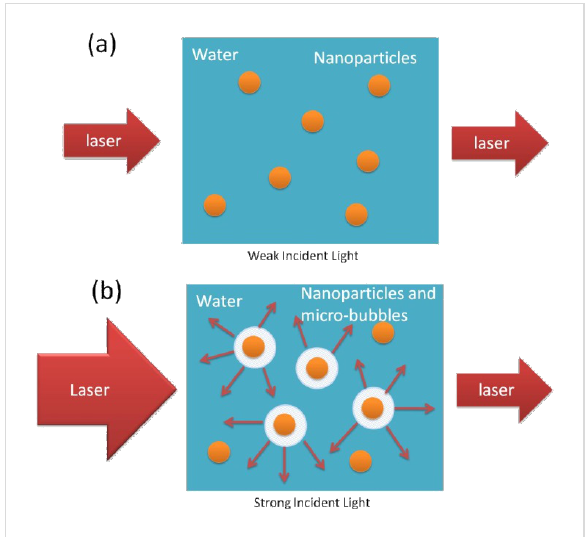
Figure 2: Schematic illustration of the optical limiting effect induced by the nonlinear scattering process. (a) The nanoparticle dispersion is almost transparent upon illumination by laser light at low laser fluence. (b) The optical limiting effect of the nanoparticles appears when microbubbles are formed at high laser